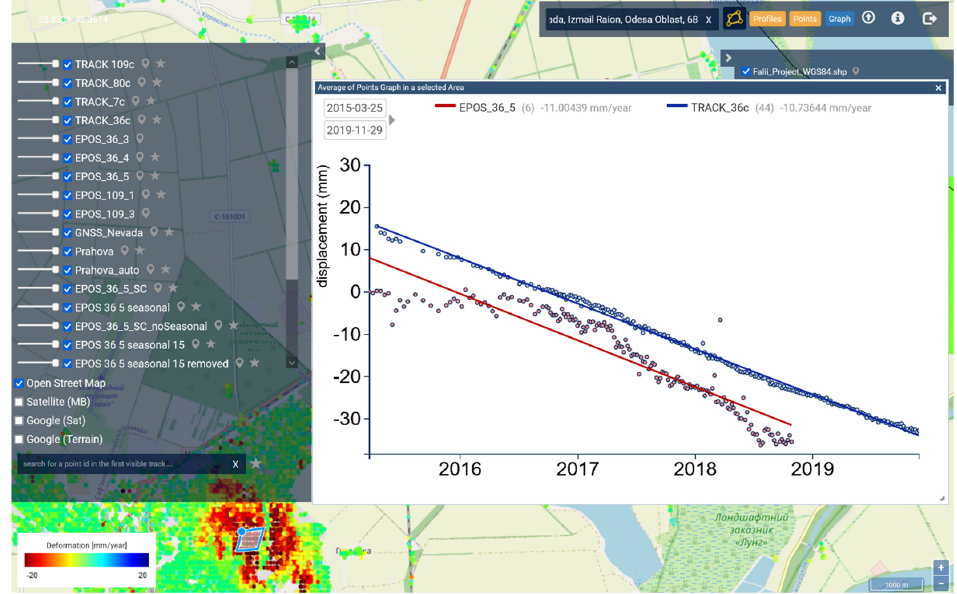
Figure 2. PSTool, an online and free-access analysis tool for ground displacement monitoring [23].